Question: In one sentence, what is this figure communicating?
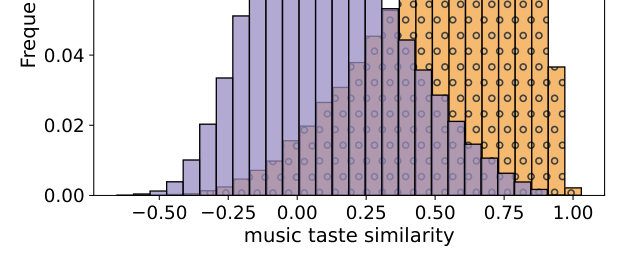
Answer: Distributions of music taste similarity for pairs of users who shared music in our sample (share) and a random permutation of those pairs (random).